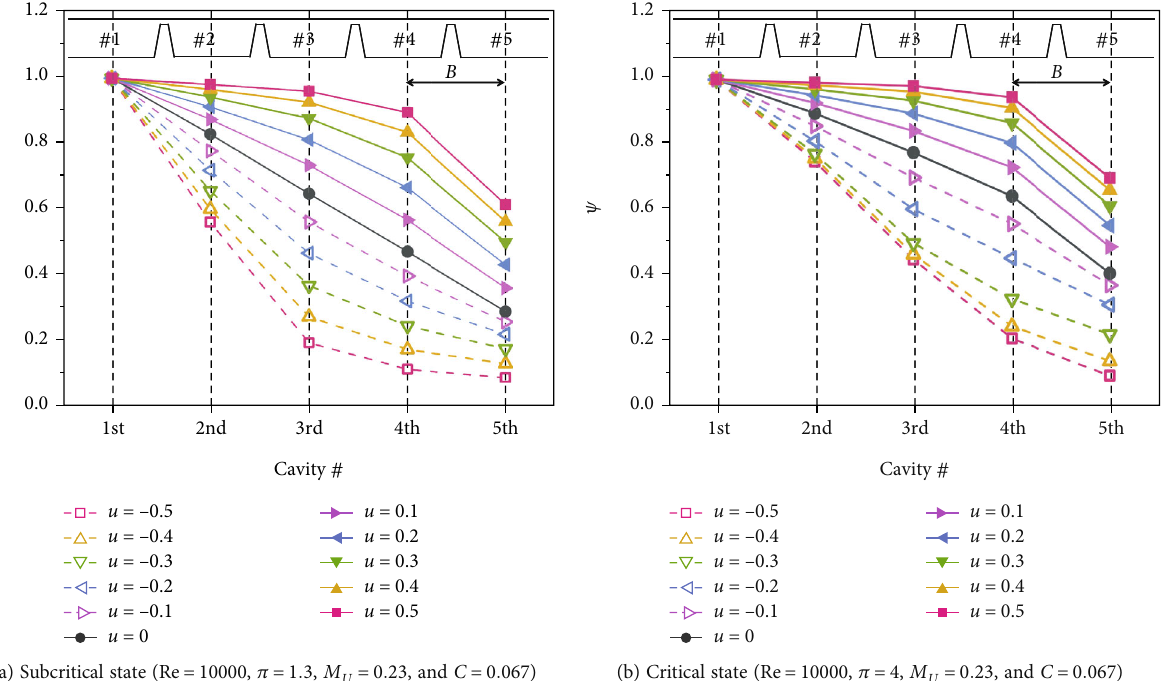
Figure 16: Total pressure distributions of di ff erent teeth cavities.